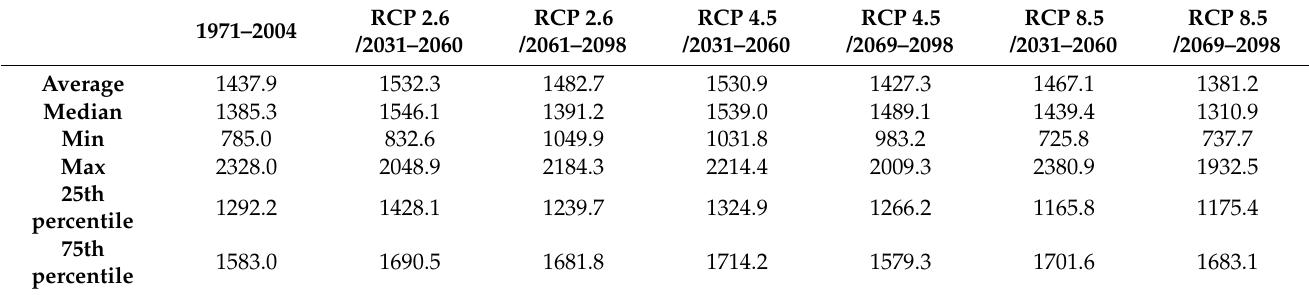
Table 2. Basic annual precipitation statistics for the reference period and climate scenarios.